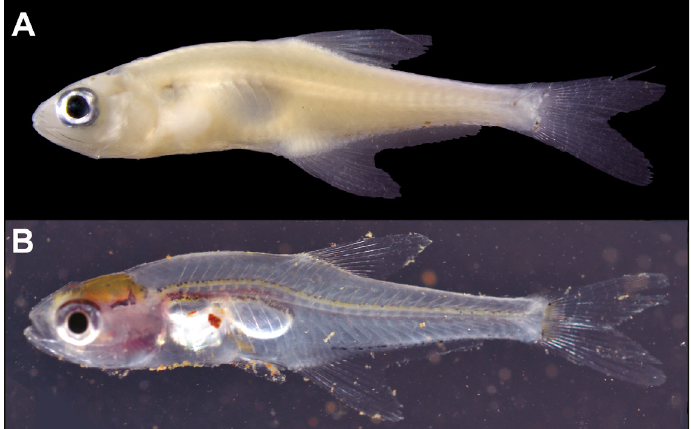
FIGURE 1 | Priocharax britzi , A. Holotype, male, MZUSP 125822, 13.7 mm SL; Brazil, Amazonas, Canutama, small lake approximately 400 m from the rio Ipixuna, after bridge crossing this river, on the right side of the Transamazônica Road (BR–230) going from Humaitá to Lábrea, rio Ipixuna drainage. B. Live paratype photographed immediately after capture. TABLE 2 | Morphometric data of Priocharax britzi . N = number of specimens; SD = standard deviation. Range includes the holotype. [Note: In the recent description of Priocharax varii (Mattox et al ., 2020:423, table 2), data of anal-fin length is incorrect. The correct information is as follows: Holotype = 22, range = 20–24, mean = 21.8, SD = 0.9, with n = 48 including the